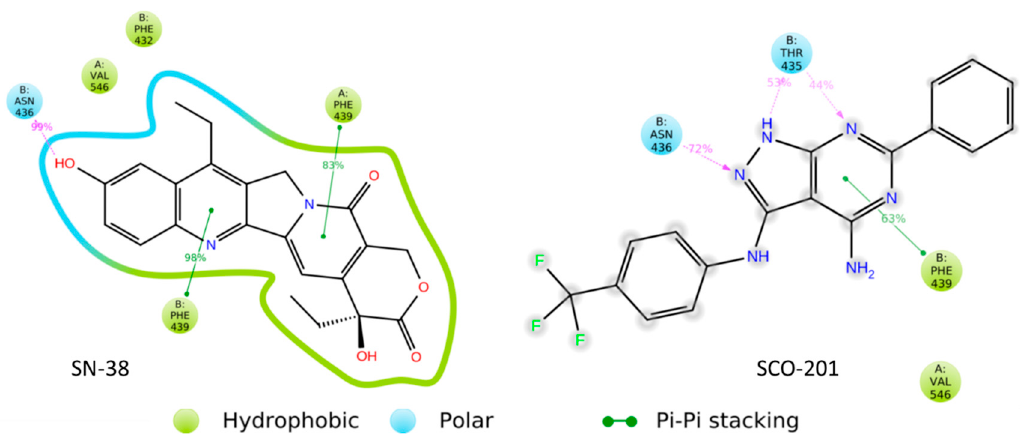
Figure 7. Binding interactions shown between SN-38 (left) and SCO-201 (right) to the transporter BCRP. Both molecules interacted with the PHE-439 residue of the B chain of BCRP. The interaction percentages indicate accounting for number of frames over the 10 ns simulation where the binding was present. Timetable of ligand–protein interactions are available in Figures S7 and S8. Interactions shown were present in over 30% of the simulation frames. Graphical representation was produced using Desmond, Schrödinger, 2019-3, LLC [43].